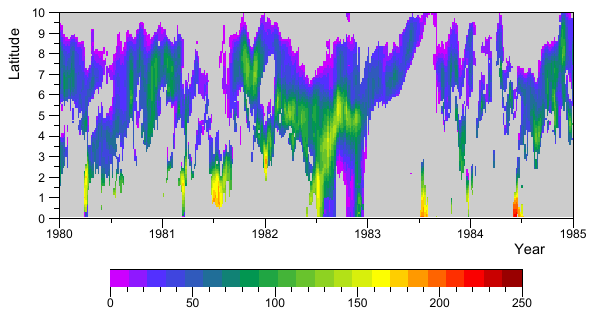
Figure 16. Eastward transport (m 2 s − 1 ) of the NECC across 180 ◦ E, plotted as a function of latitude and time. The transport here is defined as the integral of the eastward component of velocity from the surface to the first level where it is negative. It is zero if the sur- face velocity is westward.